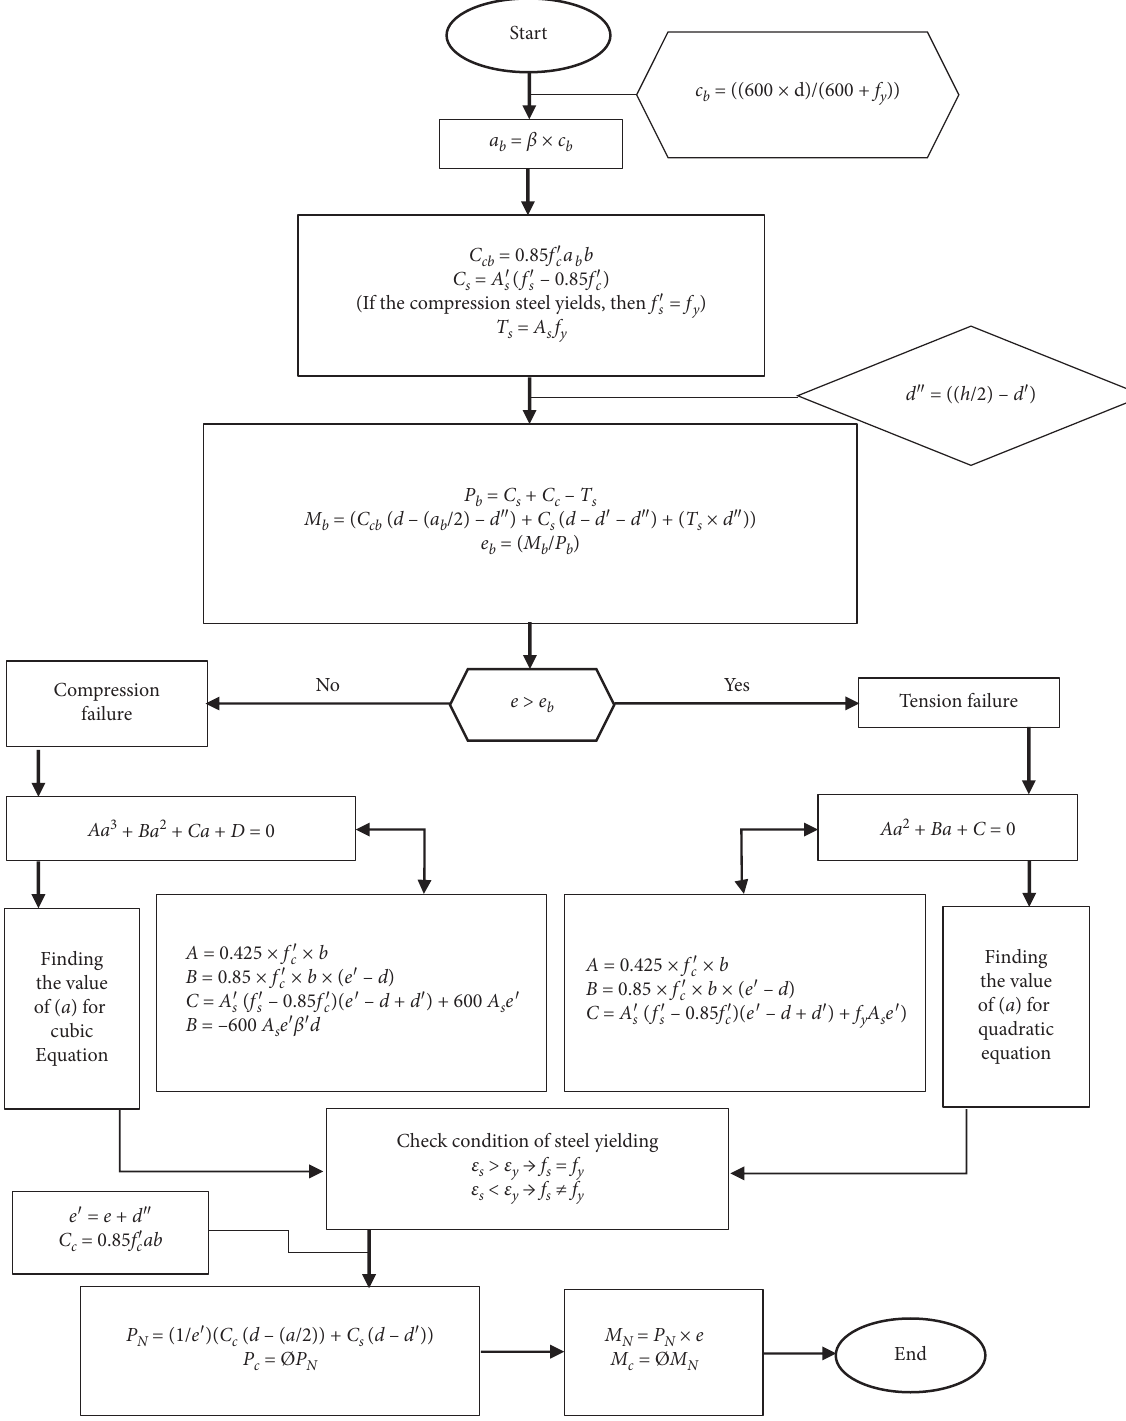
Figure 6: Flow chart of the mathematical model for the rectangular uniaxial rectangular